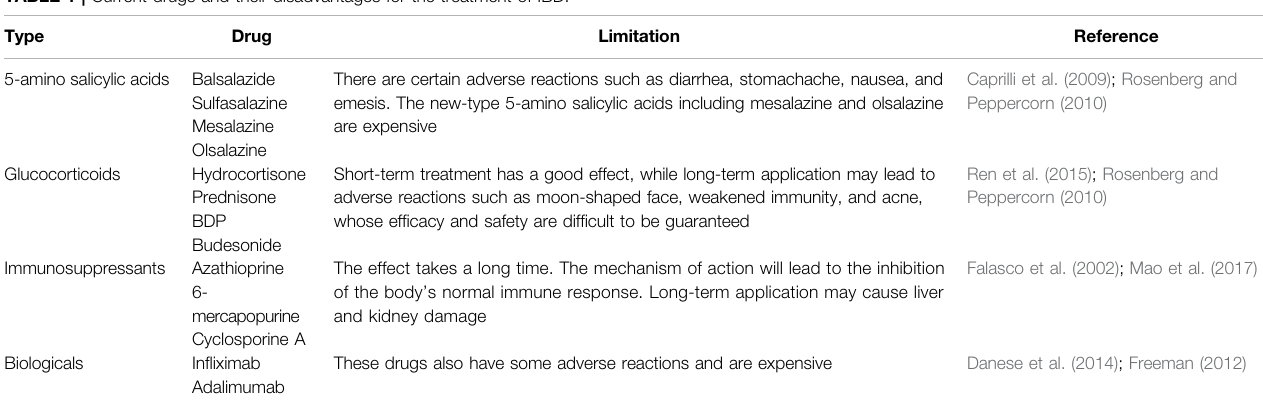
TABLE 1 | Current drugs and their disadvantages for the treatment of